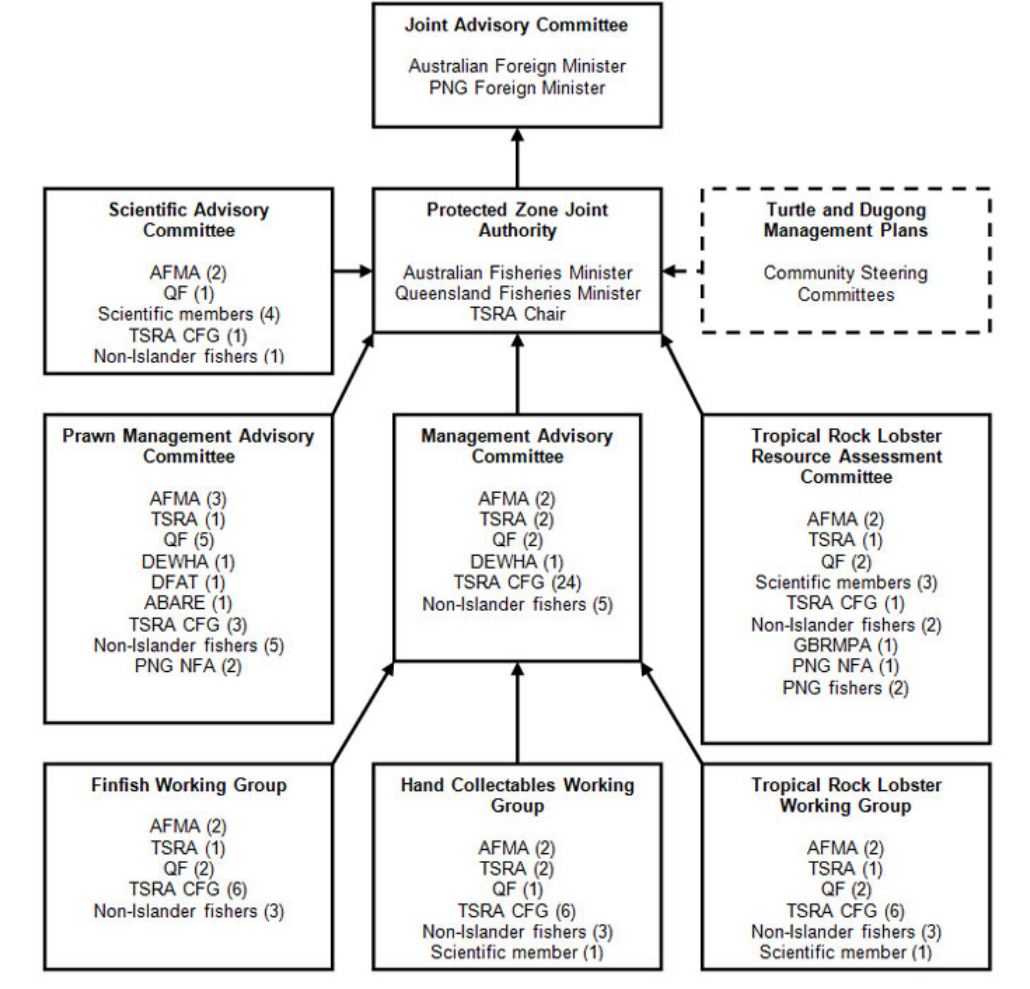
Fig. 2 . The Torres Strait Protected Zone Joint Authority (PZJA) consultative committee framework, stakeholder groups, and their voting representatives’ numbers (summarized from PZJA 2008). Abbreviations are: Australian Fisheries Management Authority (AFMA), Torres Strait Regional Authority (TSRA), Queensland Fisheries (QF), TSRA Community Fisher Group (CFG), Department of Environment, Water, Heritage and the Arts (DEWHA), Department of Foreign Affairs and Trade (DFAT), Australian Bureau of Agricultural and Resource Economics (ABARE), Great Barrier Reef Marine Park Authority (GBRMPA), Papua New Guinea National Fisheries Authority (PNG